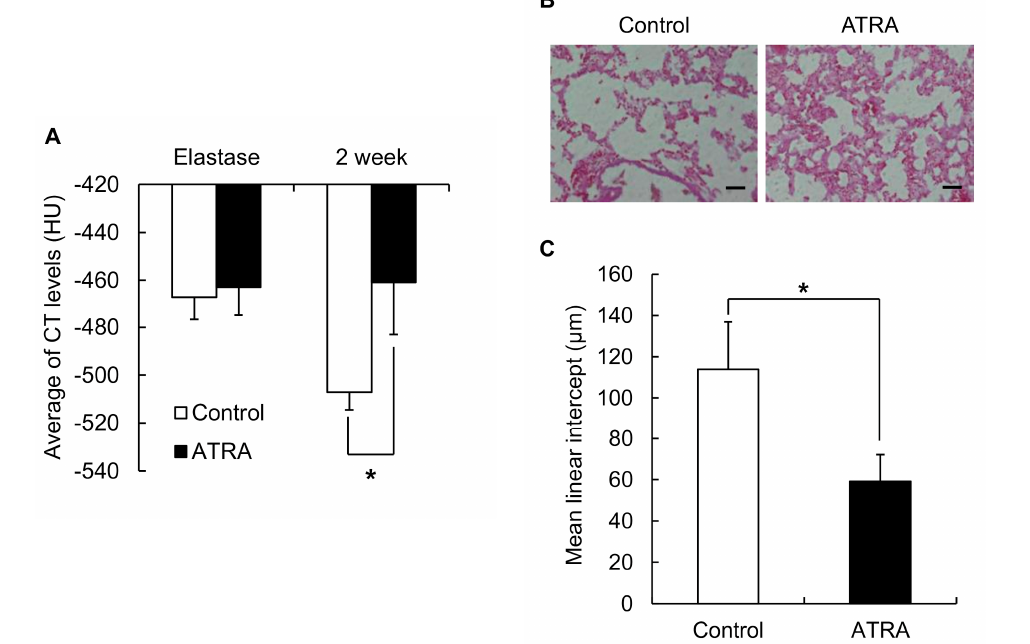
Figure 5. All-trans-retinoic acid (ATRA)-abrogated alveolar wall distance in elastase-induced chronic obstructive pulmonary disease model mice. ( A ) The average CT value, ( B ) lung sections (hematoxylin and eosin stain), and ( C ) the average air space in the mice treated with 2.5 mg / kg ATRA and in the control group at 2 weeks after the administration of ATRA. Scale bar = 40 µ M. Data represent the mean ± S.E. * p < 0.05 (Student’s t -test) ( n = 8 for the control group and n = 6 for ATRA in the treatment group, p = 0.047).